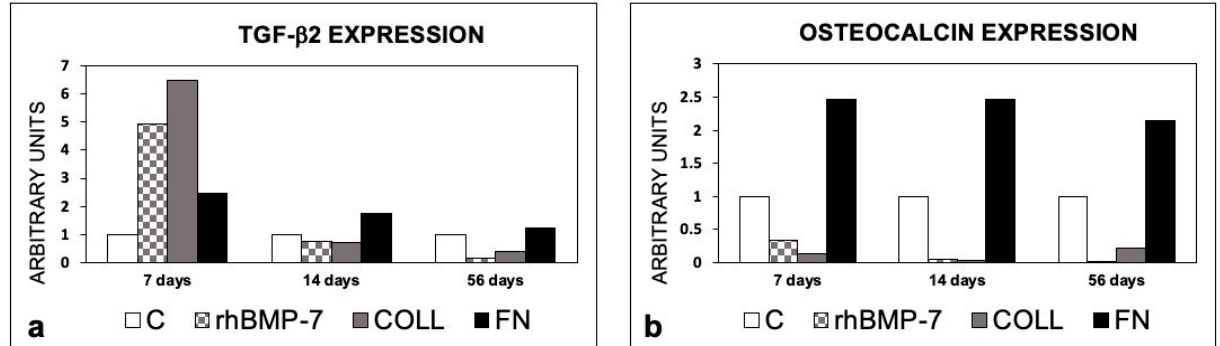
Figure 9. Expression of TGF- β 2 and Osteocalcin in peri-implant bone tissues from sites treated with rhBMP-7, Type 1